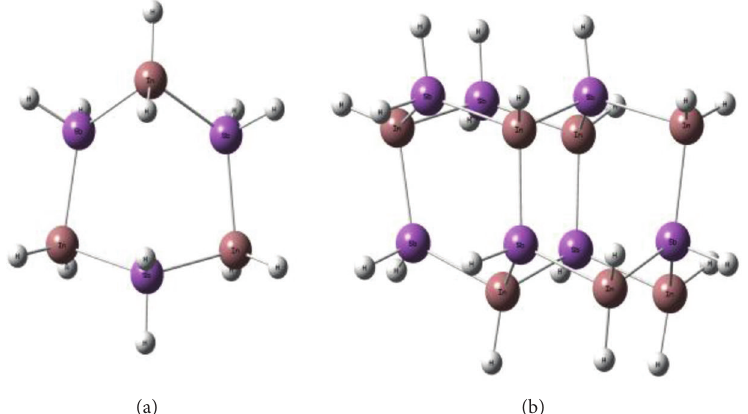
Figure 1: Shape of geometrically optimized (a) In 3 Sb 3 H 12 and (b) InSb-diamantane. PBE/3-21G method is used for the present figure.